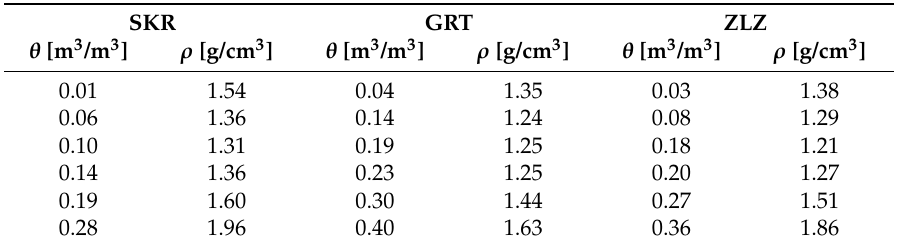
Table 3. Density of